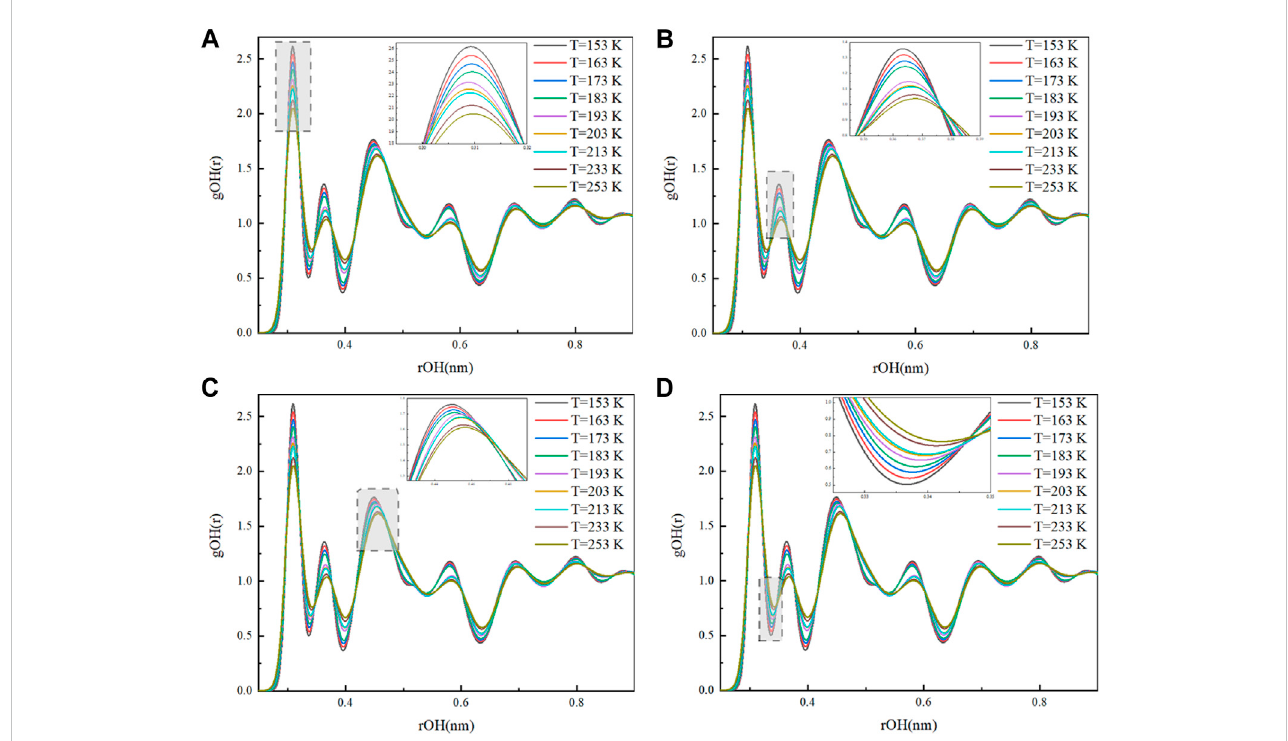
FIGURE 8 Peaks and valleys of the O-H radial distribution [ (A) : fi rst peak; (B) second peak; (C) third peak; (D) fi rst valley].